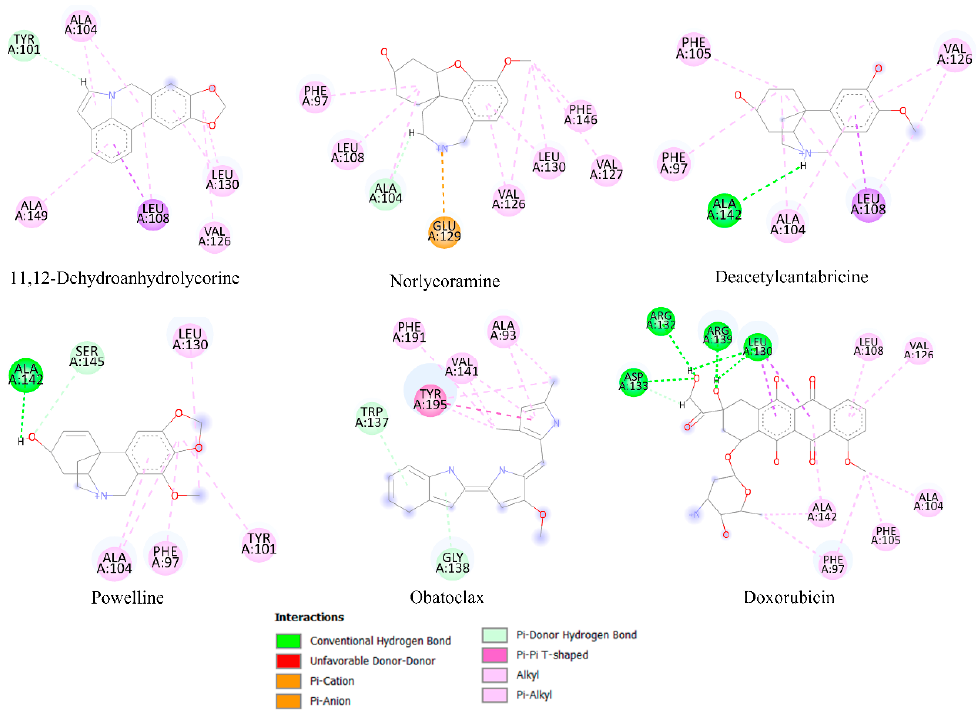
Figure 4. Principal interactions located by the molecular docking experiments between the ligands 11,12-dehydroanhydrolycorine, norlycoramine, and deacetylcantabricine and Mcl-1 protein.